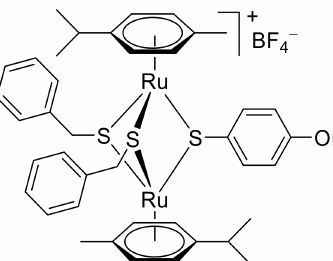
Figure 4. Structure of complex J , [( η 6 -p -MeC 6 H 4 Pr i ) 2 Ru 2 ( µ 2 -SCH 2 -C 6 H 5 ) 2 ( µ 2 -SC 6 H 4 -p- OH)]BH 4. Data from ref. [97].